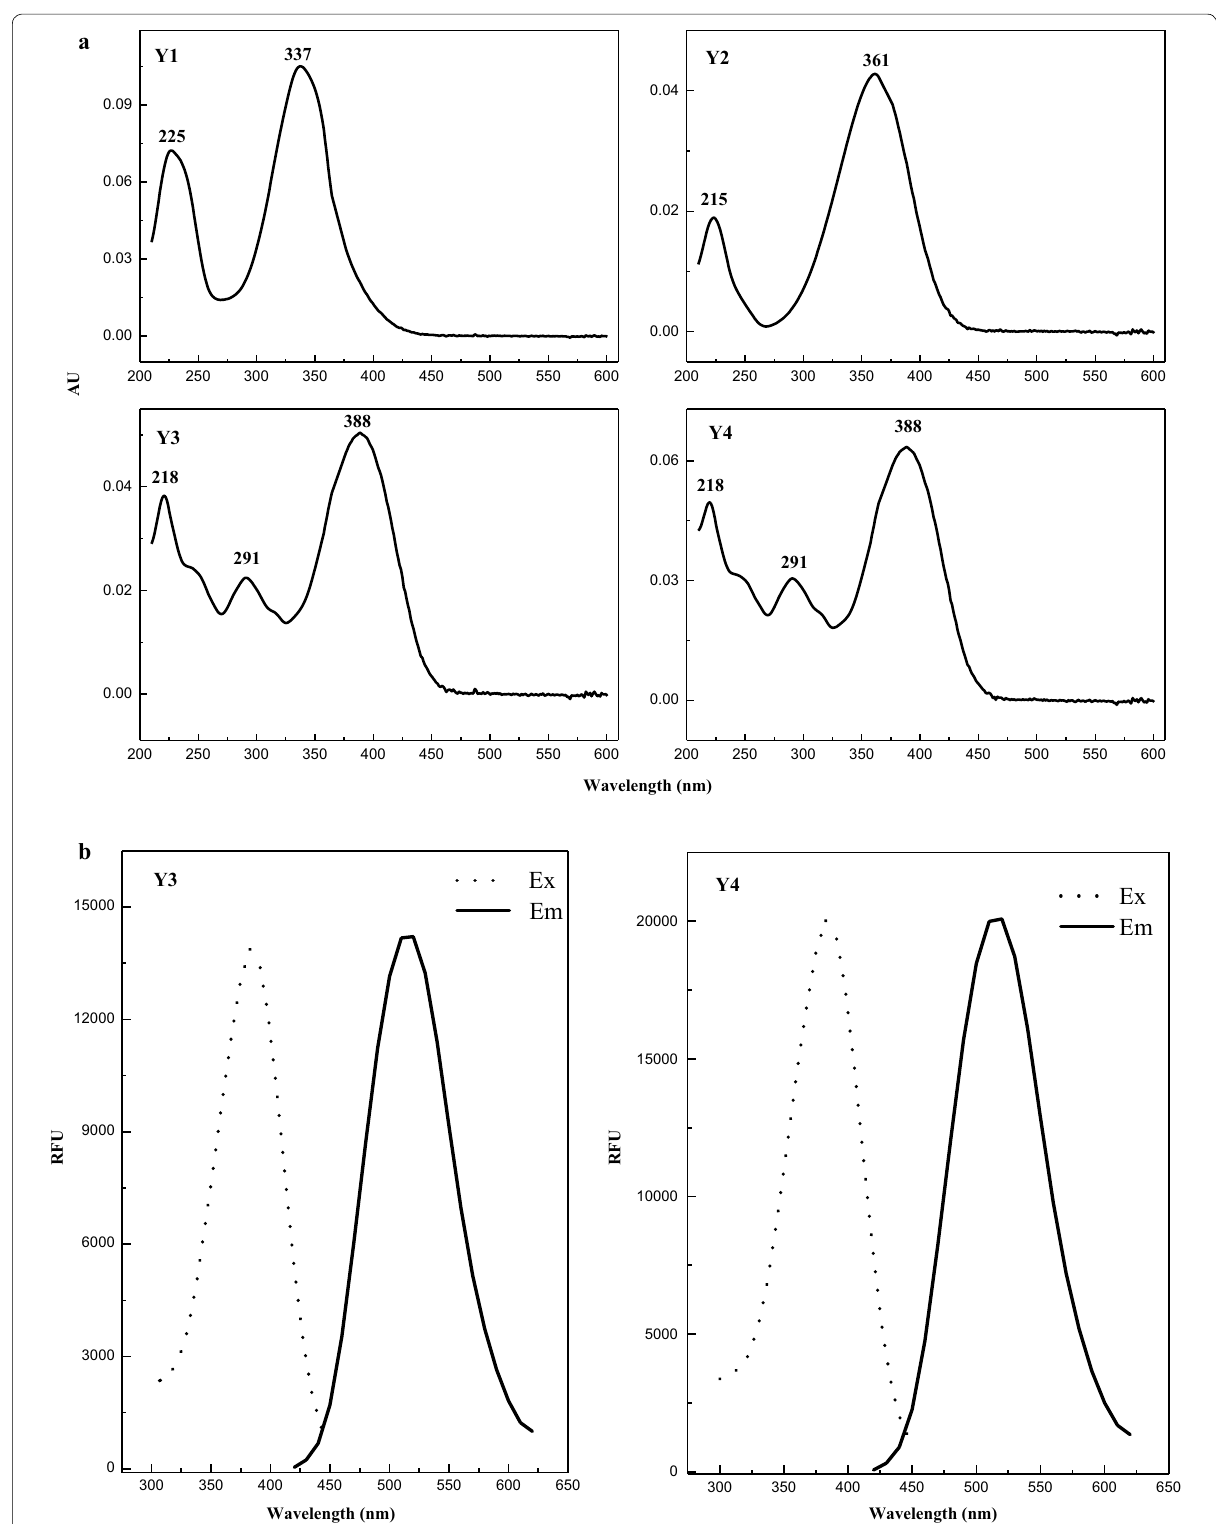
Fig. 2 a UV–Visible spectra of extracellular water-soluble yellow pigments detected by HPLC-PDAD. Y1 , retention time at approximately 12.3 min; Y2 , retention time at approximately 13.3 min; Y3 , retention time at approximately 17.2 min; Y4 , retention time at approximately 20.1 min. b Excita- tion and emission spectra of Y3 and Y4 detected by HPLC-FLD, λ ex